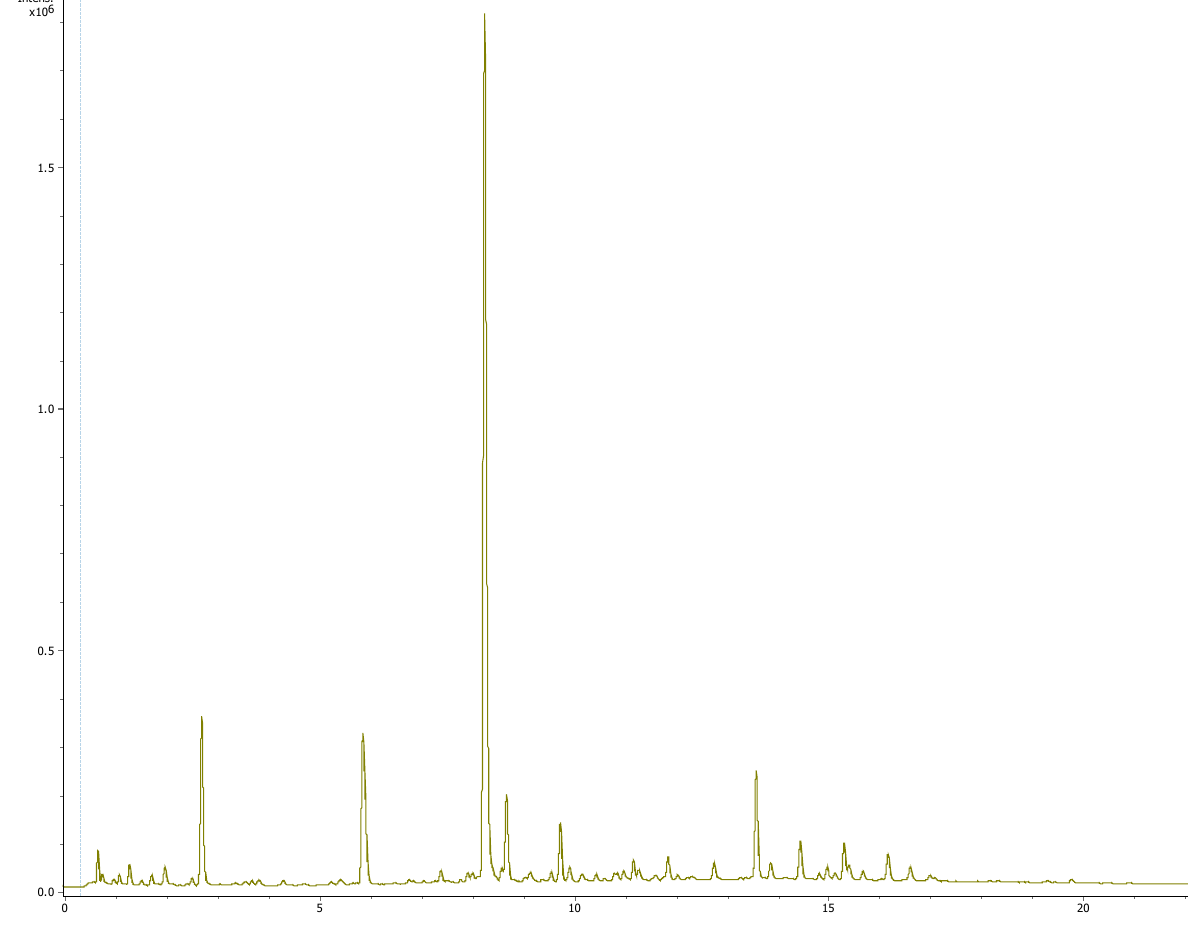
Figure A7. Ilex × meserveae ‘Blue Angel’ leaves water extract, UV chromatogram, 280